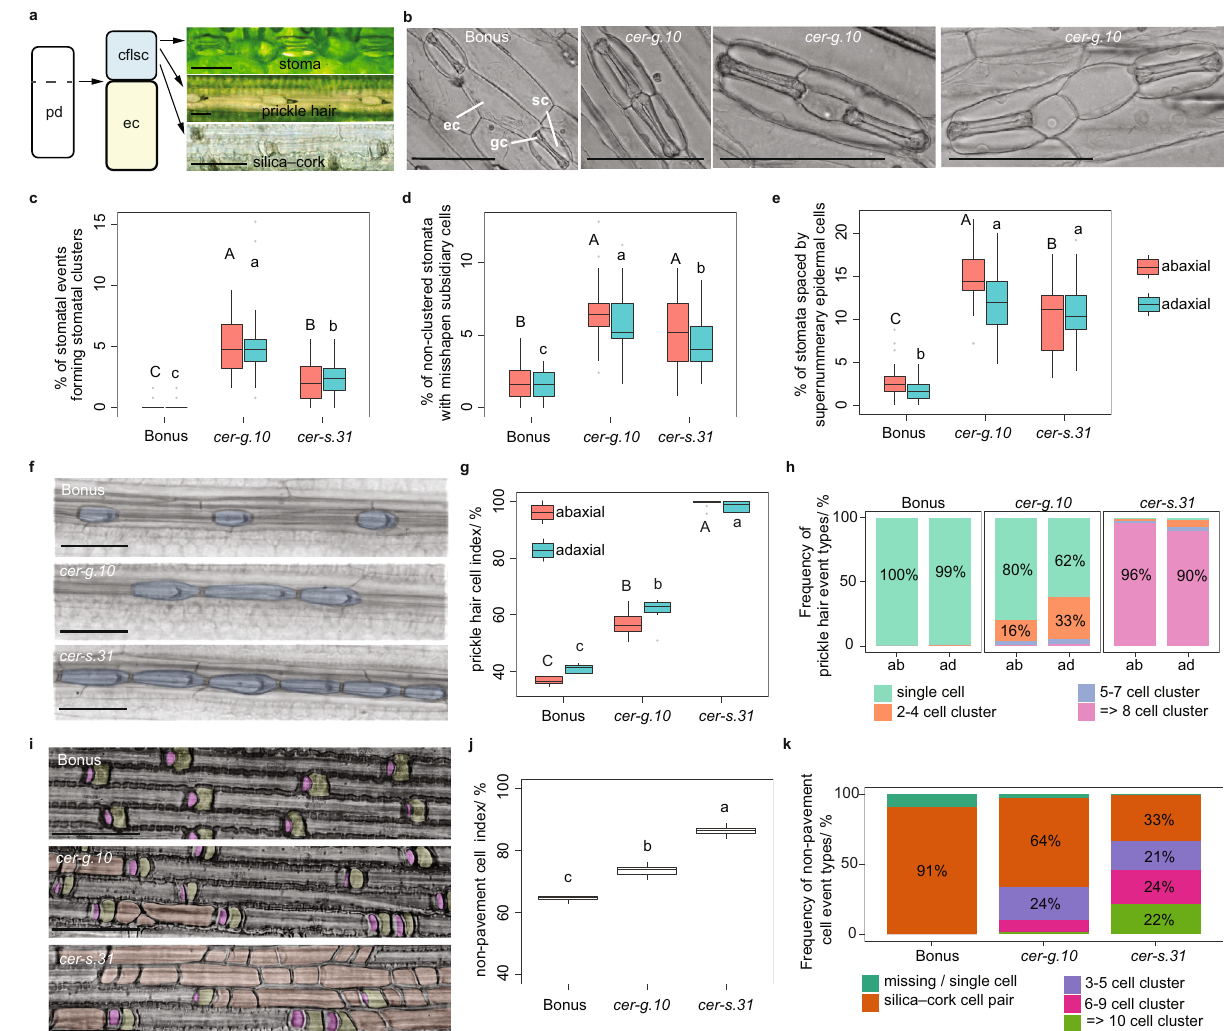
Fig. 2 | Variation in HvYDA1 and HvBRX-Solo alters epidermal patterning. a Model of epidermal differentiation. A protodermal cell (pd) undergoes asym- metric celldivision. The larger daughtercelldevelopsinto an epidermal pavement cell (ec). Depending on fi le lineage, the smaller cell fi le lineage-speci fi c cell (c fl s) differentiates into either a stoma, silica – cork cell pair or prickle hair cell. Scale bar=50 µ m. N =8 plants per cell fi le type. b The left panel shows a representative image of stomatal patterning in Bonus where stomatal complexes composed of guard cells (gc) and subsidiary cells (sc) are separated by a single epidermal cell. The right panels show representative images from cer-g.10 of the abnormal pat- terning observed in cer-g.10 and cer-s.31 . From the left: directly appressing, ‘ clus- tered ’ stomatal complexes; stomata with misshapen subsidiary cells; and a subsidiary cell extending over the neighbouring cell with supernumerary cells between the stomata. Scale bars=100 µ m. N =24 plants per cell event